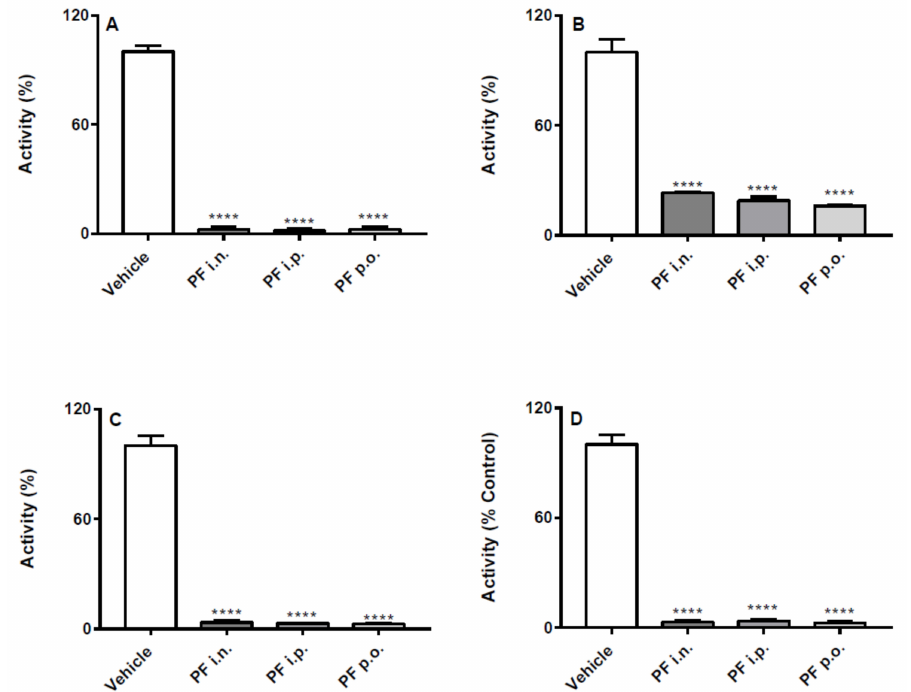
Figure 1. E ff ect of in vivo PF administration on FAAH activity. Inhibition of ( A ) hippocampus, ( B ) cortex, ( C ) cerebellum and ( D ) liver FAAH activity after the three di ff erent routes (i.n., i.p. or p.o.) of PF or vehicle administration. Results are means ± SEM expressed as percentage of the maximum e ff ect observed in absence of PF plus vehicle administrated by the di ff erent routes. **** p < 0.0001 post hoc comparisons with vehicle conditions, Tukey’s